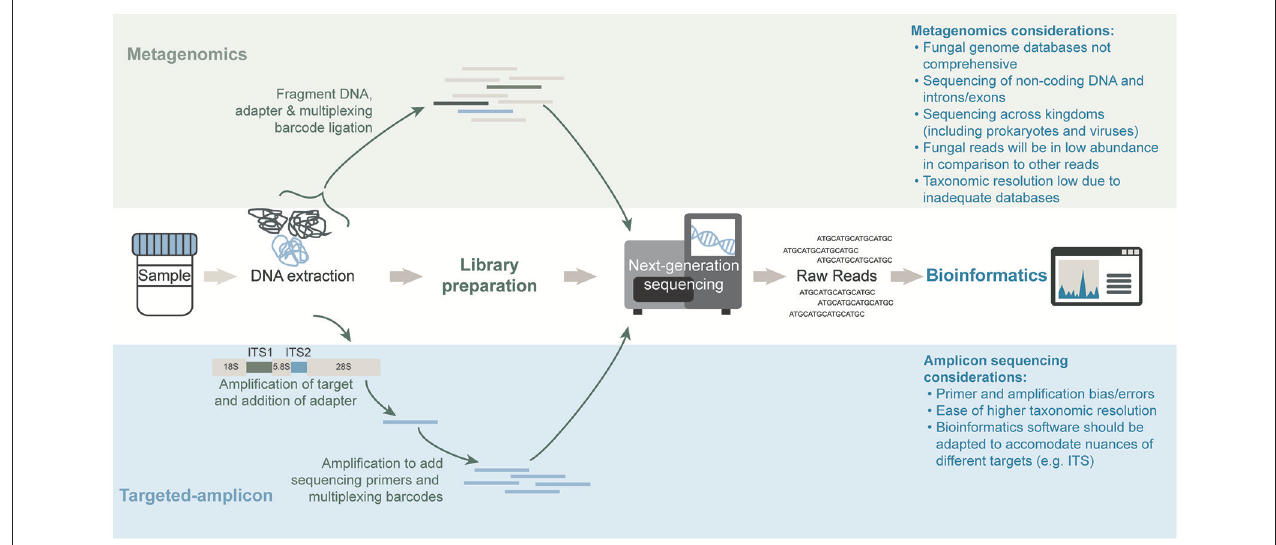
FIGURE 2 | General workflows for mycobiota characterization of a shotgun metagenomics short-read sequencing approach ( top ) and targeted-amplicon sequencing of a phylogenetically informative fungal marker ( bottom ). Sequencing methods differ significantly in both approaches. The library preparation step in an amplicon sequencing approach requires an amplification step to generate the material for high-throughput sequencing whereas a metagenomics approach prepares the total genomic DNA content in a sample for high-throughput sequencing. Lastly, bioinformatics analysis of the raw reads for each method differs significantly in databases and software